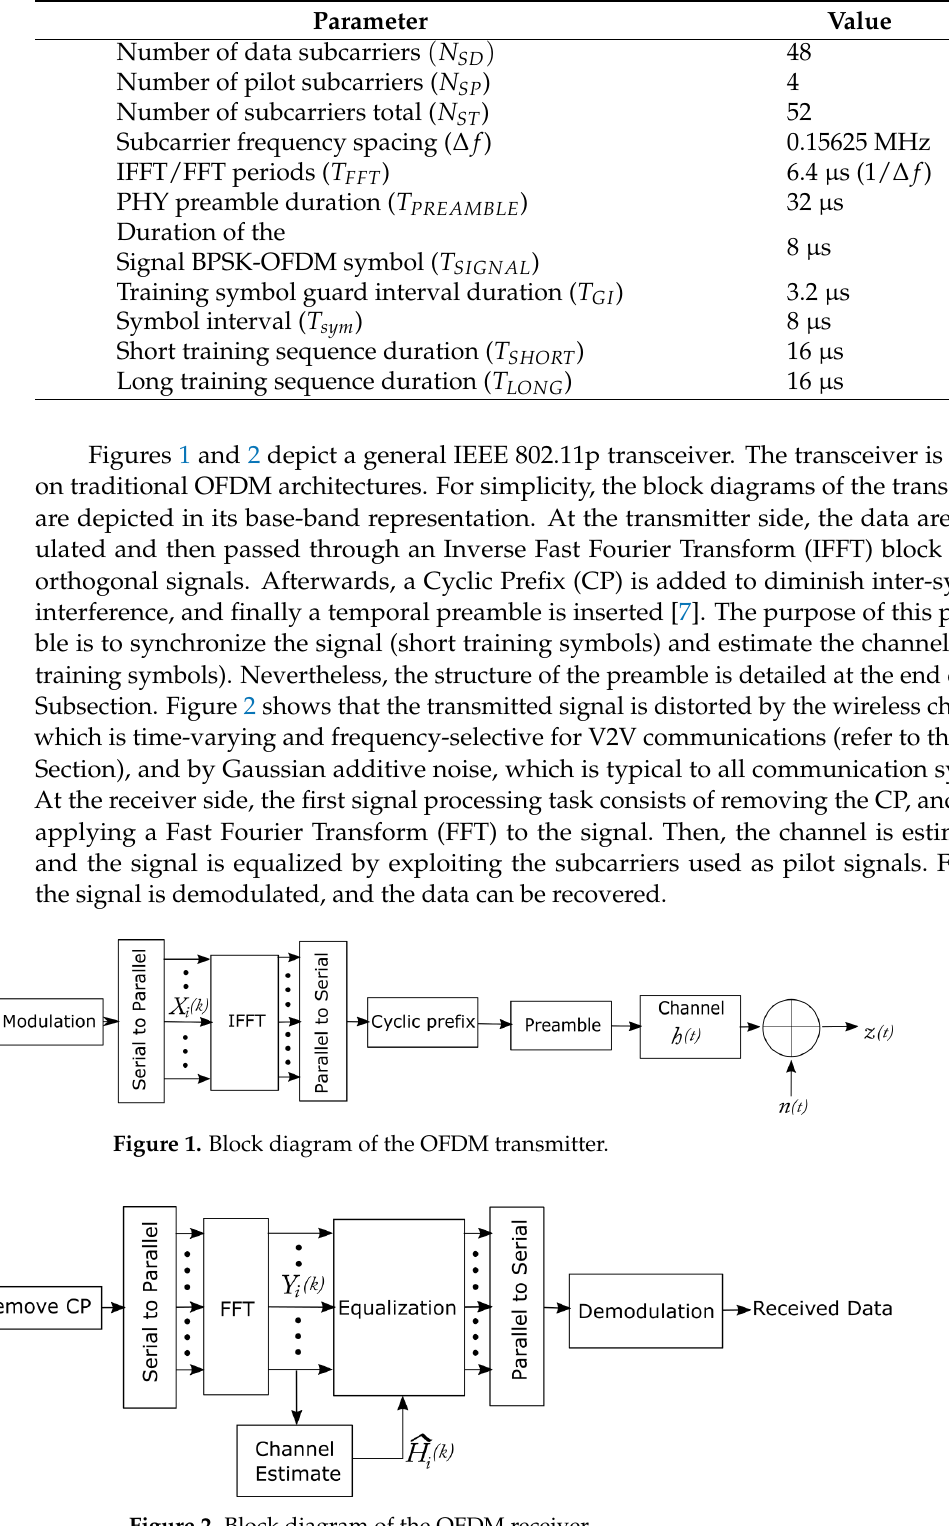
Figure 2. Block diagram of the OFDM